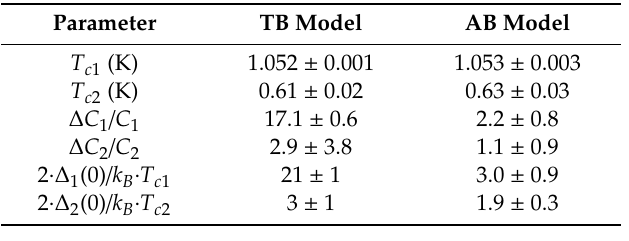
Table 2. Deduced parameters for tantalum / graphene / tantalum (Ta / G / Ta) junction at V g = 10 V from fit to two-band Titov and Beenakker (TB) [53] and Ambegaokar and Barato ff (AB) [7,8] models. Parameter